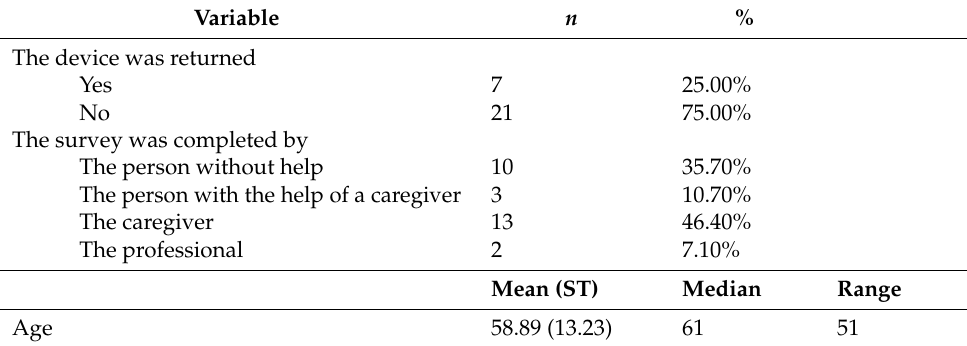
Table 2. Score obtained for dimensions of the Psychosocial Impact of Assistive Device Scale (PIADS) and the Assistive Technology Device Predisposition Assessment (ATD PA) device form.